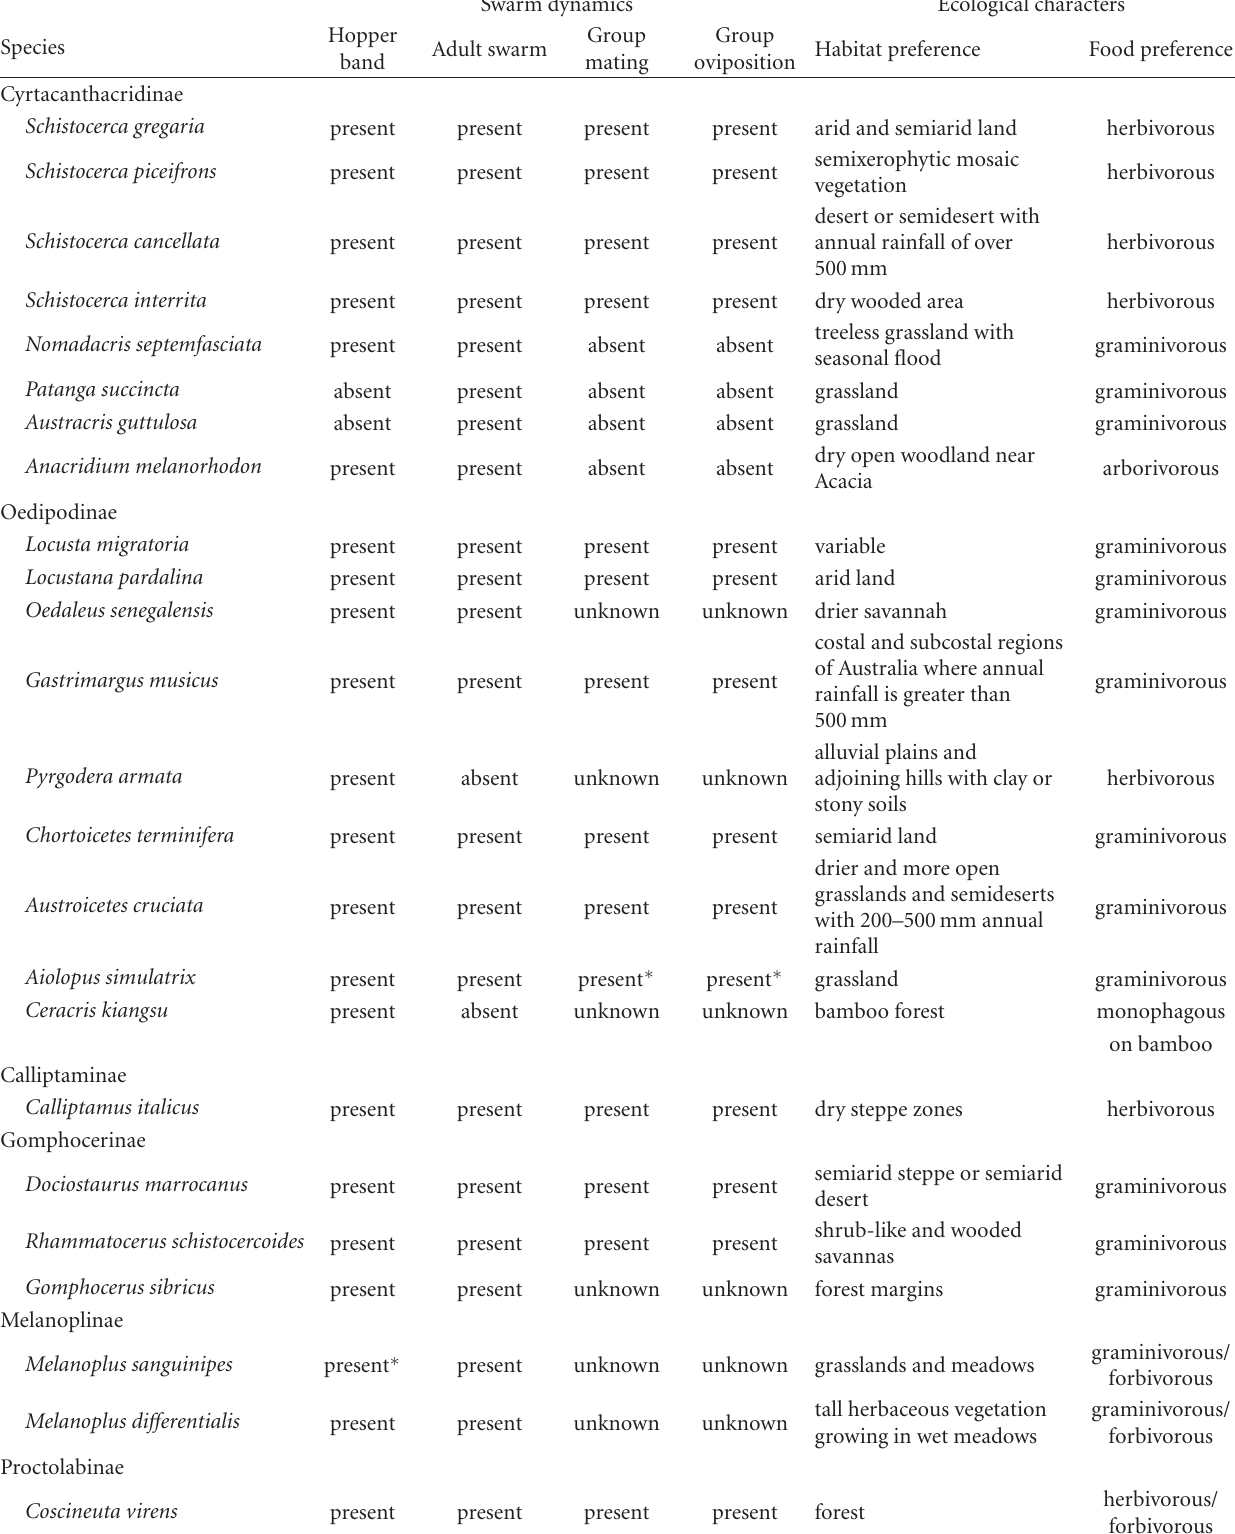
Table 2: Expressions of swarm dynamics and ecological characteristics of the species included in this paper. When there is conclusive evidence on presence or absence of a given phenomenon, it is noted as such. Asterisk denotes the possibility based on inconclusive and anecdotal evidence. Unknown denotes the lack of quantitative